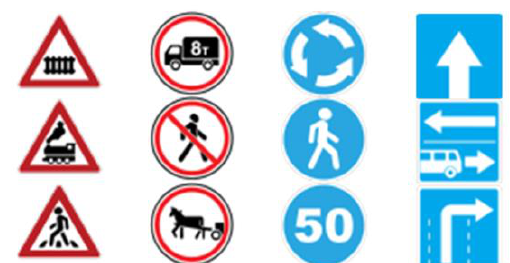
Figure 1: Column-wise examples of traffic sign types (red triangles, red circles, blue circles, blue squares) processed by our system.